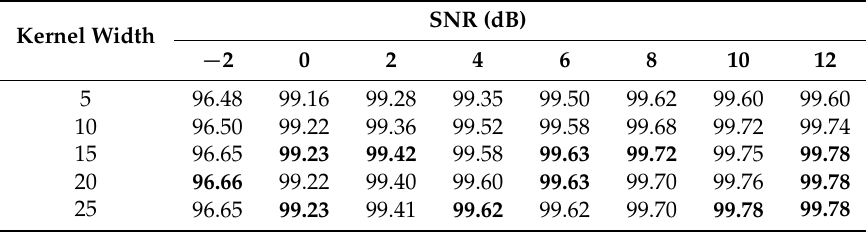
Table 9. Diagnosis accuracy (%) of AICNN-1D with different kernel width of the first convolution layer. SNR (dB) Kernel Width −